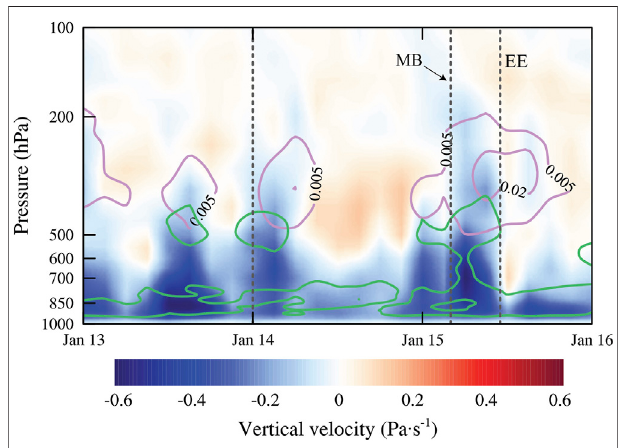
FIGURE 4 | Time series of averaged vertical velocity (shading), cloud ice water content (purple contours at 0.005, 0.02 gkg − 1 ), and cloud liquid water (green contours at 0.035 g kg − 1 ) content within a radius of 150 km of Cody every 3 h from 0000 UTC on January 13 to 0000 UTC January 16. The threedashedverticallinesdenotethethreemoments:theweakeruptionofthe Tonga volcano on January 14, the main blast (MB), and the end of eruption (EE).